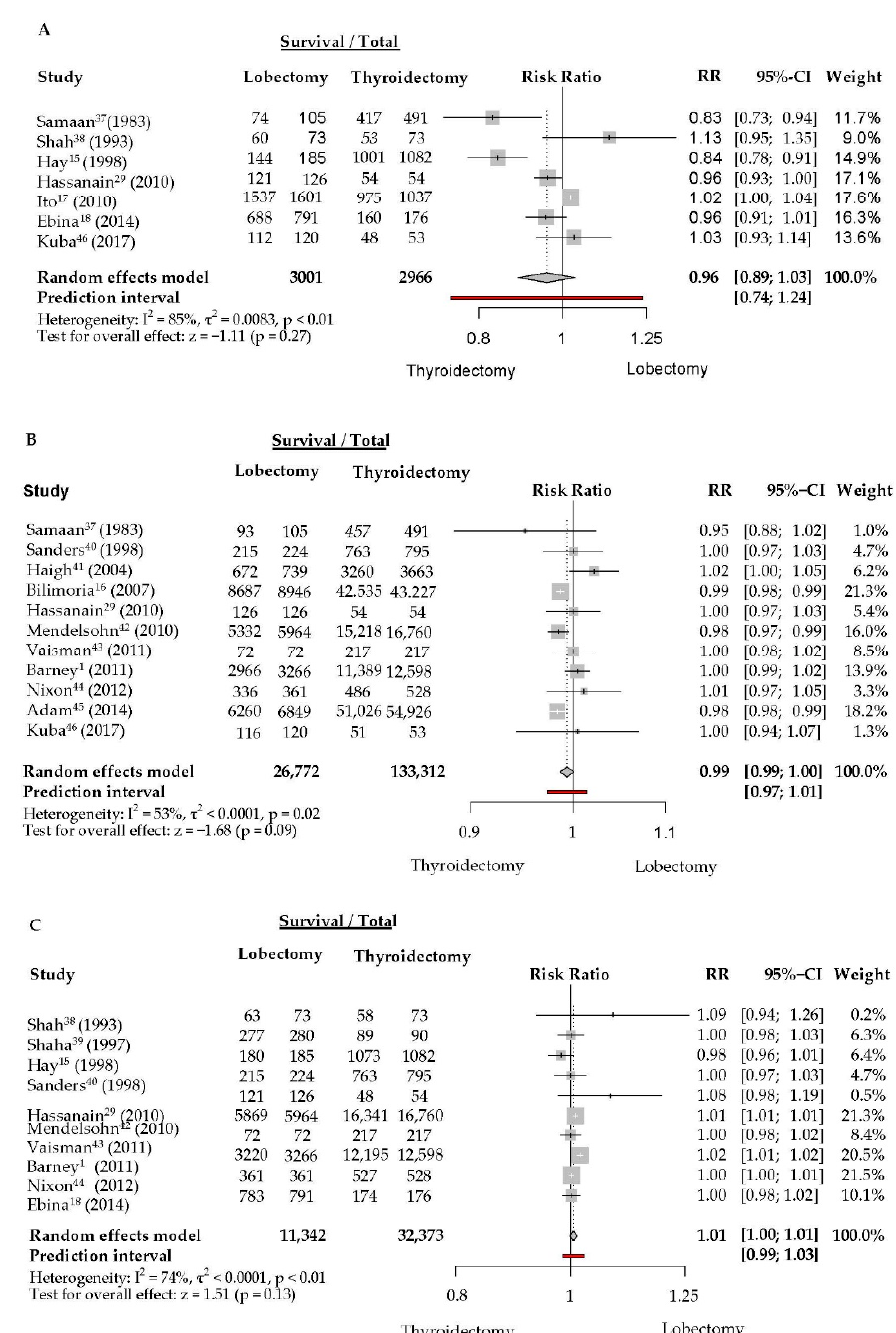
Figure 3. Survival rates of thyroid carcinoma after total thyroidectomy versus lobectomy. ( A ) DFS; ( B ) OS; ( C )